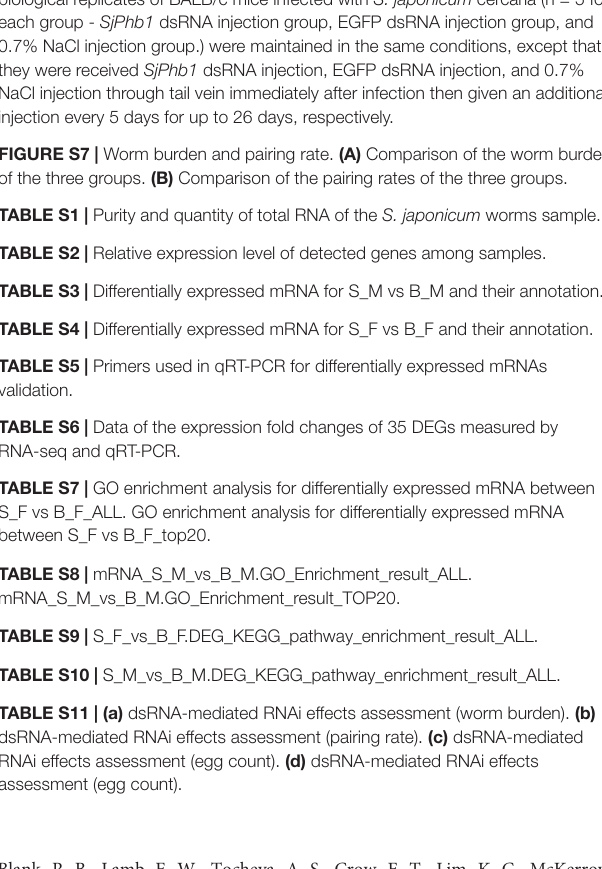
FIGURE S1 | Sample relationships revealed by transcriptome profiles between worm samples. (A–F) Scatter plots of Pearson’s correlation analysis based on the transcriptome profiles between worm samples. The figures in the matrix R 2 are the square of the correlation coefficient (r) between two samples. FIGURE S2 | Validation of a subset of DEGs by qRT-PCR. Thirty-five differentially expressed genes in female or male worms between SCID mice and BALB/c mice